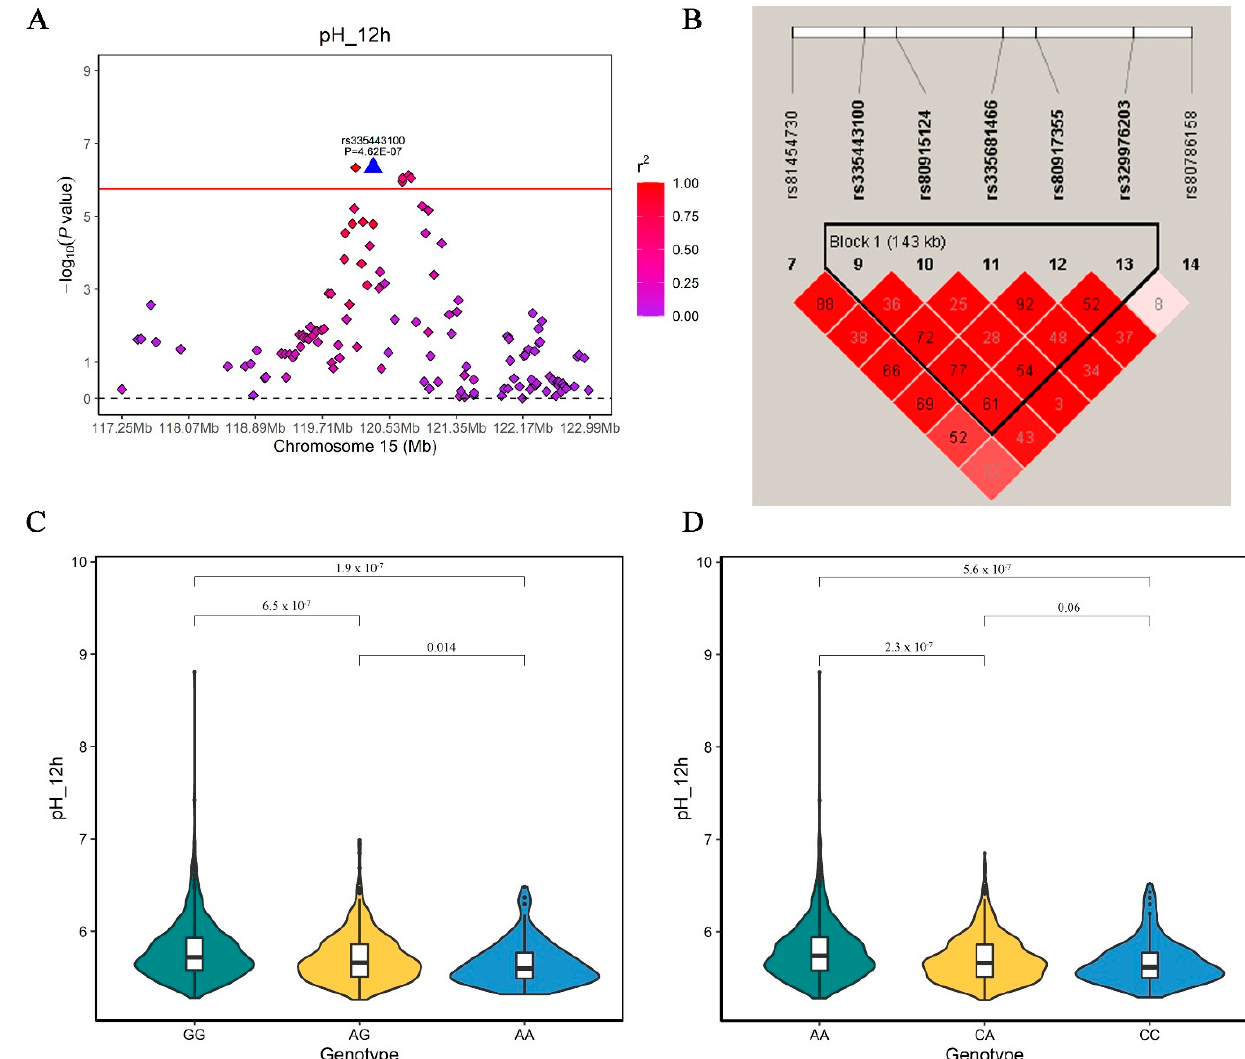
Figure 5. ( A ) Regional plots of rs335443100 at 117.25–122.99 Mb on SSC15 for meat pH_12h in DLY pigs. ( B ) represents the 143 kb linkage disequilibrium block in the significant region on SSC15. ( C ) Violin plot showing the differences in meat pH among three genotypes of the GWAS top SNP (rs335443100). ( D ) Violin plot showing the differences in meat pH among three genotypes of the SNP explaining the most phenotypic variance within TTLL4 gene.